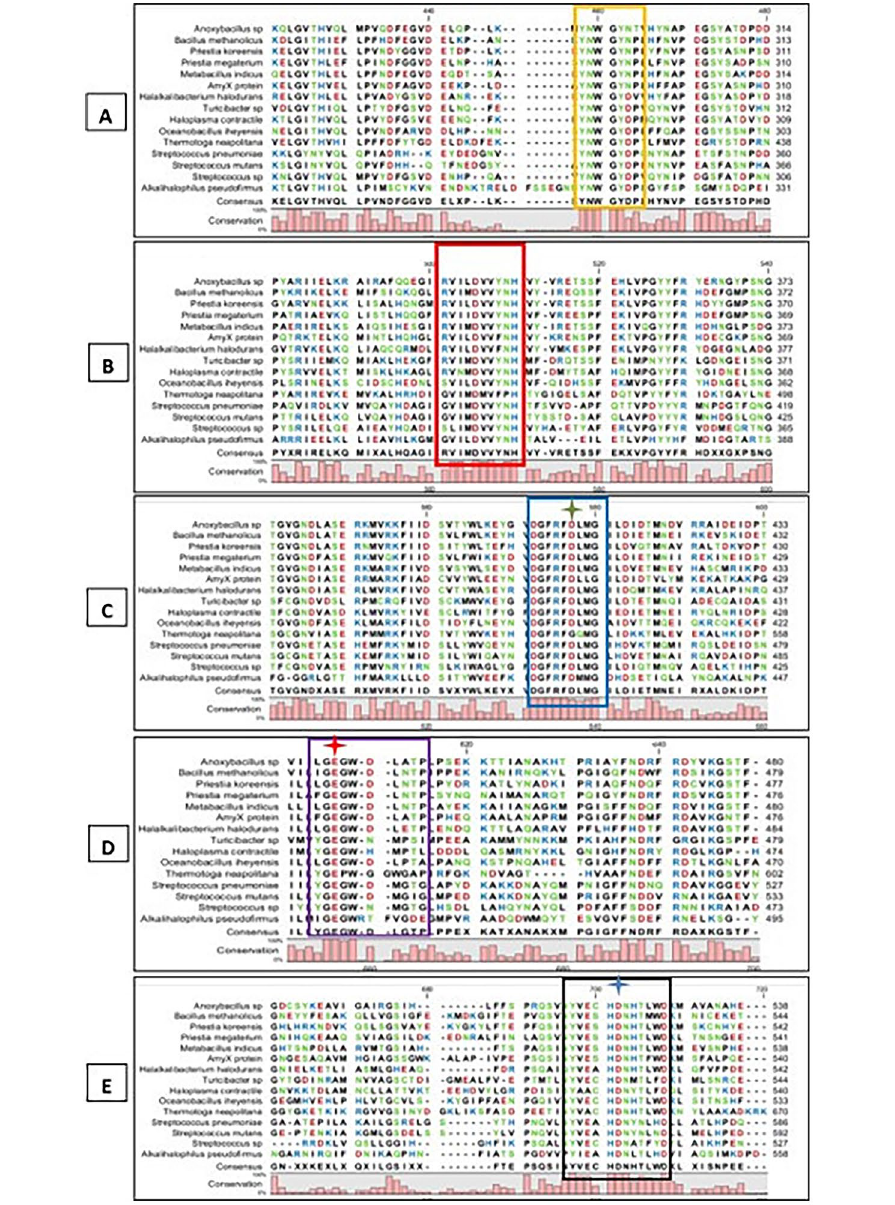
Fig. 6 Multiple sequence alignment between Pull_Met and other pullulanases type I from other species. A : the amino acid sequence of pullulanase type I signature motif highlighted by rectangle. B : the amino acid sequence of conserved region I in GH13 family highlighted by rectangle. C : the amino acid sequence of conserved region II in GH13 family highlighted by rectangle. D : the amino acid sequence of conserved region III in GH13 family highlighted by rectangle. E : the amino acid sequence of conserved region IV in GH13 family highlighted by rectangle. The accession number of pullulanases were AEW23439.1 ( Anoxybacillus sp.), WP_004439017.1 ( B. methanolicus ), WP_251605681.1 ( Priestia koreensis ), UJT32179.1 ( Priestia megaterium ), UZX50359.1 ( M. indicus ), 2E8Y (AMyx protein of Bacillus cereus ), WP_068759737 ( Turicibacter sp.), WP_010899405.1 ( Halakalibacterium halodurans ), WP_011064811.1 ( Oceanobacillus iheyensis ), WP_008826932.1 ( Haloplasma contractile ), ACN58254.1 ( Thermatoga neapolitana ), WP_002277520.1 ( Streptococcus mutans ), WP_000283071.1 ( Streptococcus pneumoniae ), WP_067193616.1 ( Strreptocccus sp.), and AVI10282.1 ( Alkalihalophilus pseudofirmus ). The catalytic triad resi- dues: Asp, Glu, and Asp are indicated by